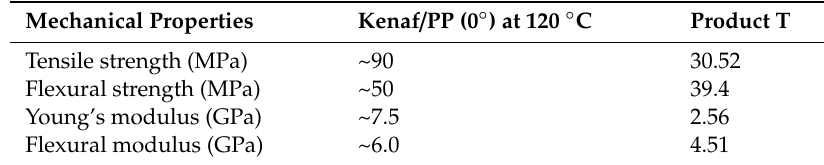
Figure 4. Flexural strength and flexural modulus of kenaf/PP composites at different temperatures.